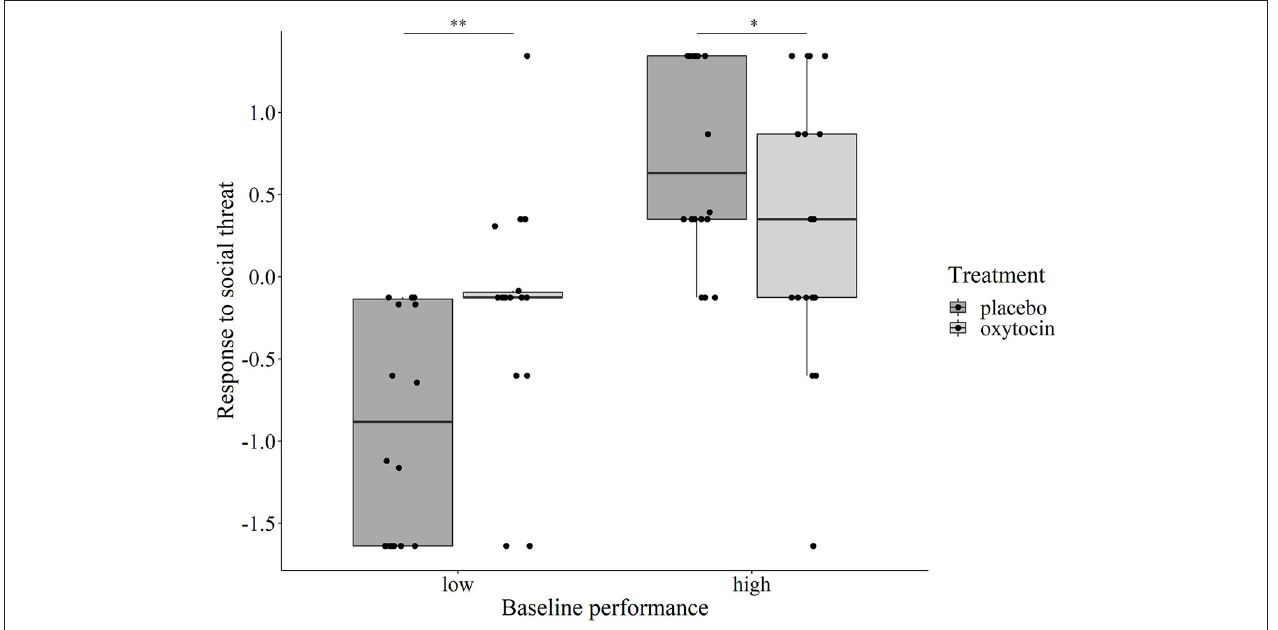
FIGURE 4 | Relationship between the dogs’ baseline performance and oxytocin/placebo treatment on their Non-aversive response to social threat component score. Oxytocin treatment significantly increased the component score in dogs with low baseline performance (** p = 0.002), while the effect of treatment was the opposite in dogs with high baseline performance (* p =